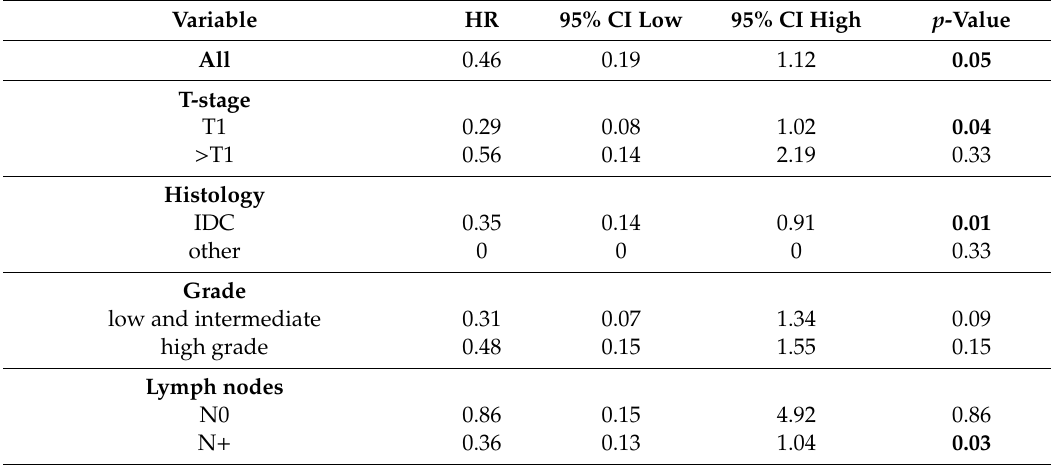
Figure 1. Kaplan–Meier estimates of probabilities of disease-free survival according to plasma nucleosome status in primary breast cancer patients ( n = 92). HR = 0.46. 95% CI 0.19–1.12, p = 0.05, 0—nucleosomes below mean, 1—nucleosomes above mean. Table 5. Prognostic value of nucleosomes on disease-free survival in primary breast cancer (nucleosomes dichotomized below vs. above mean).